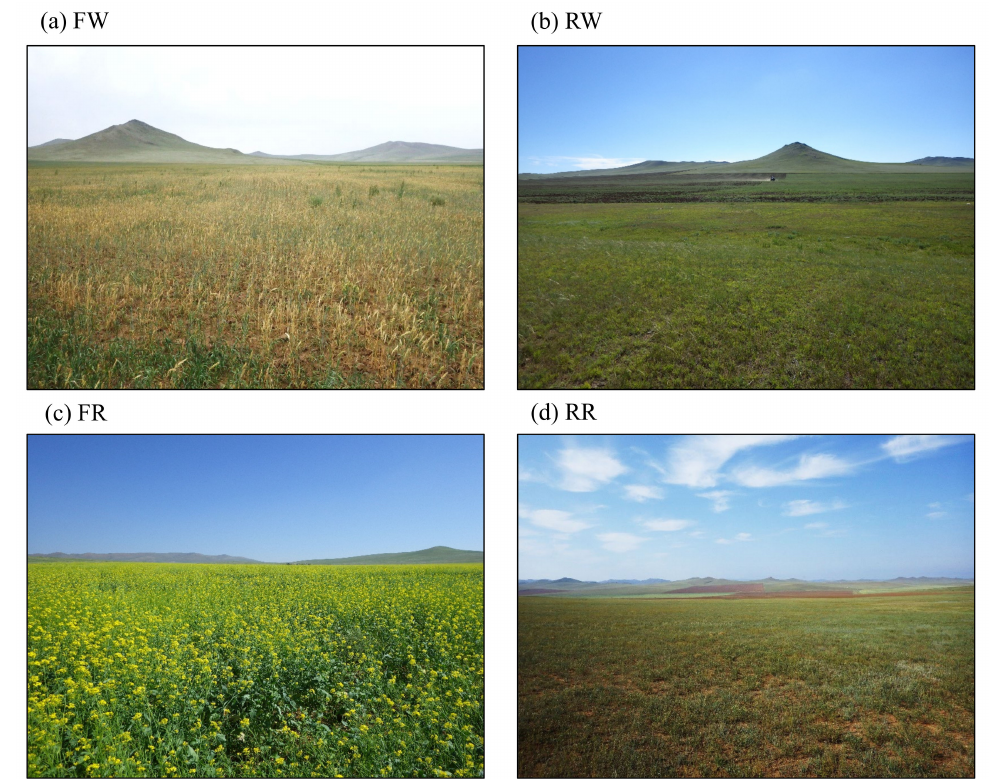
Figure 4. Photographs of the study sites taken in the summer of 2015. ( a ) Wheat field in a production year (FW), ( b ) rangeland adjacent to the wheat field (RW), ( c ) rapeseed field in a production year (FR), and ( d ) rangeland adjacent to the rapeseed field